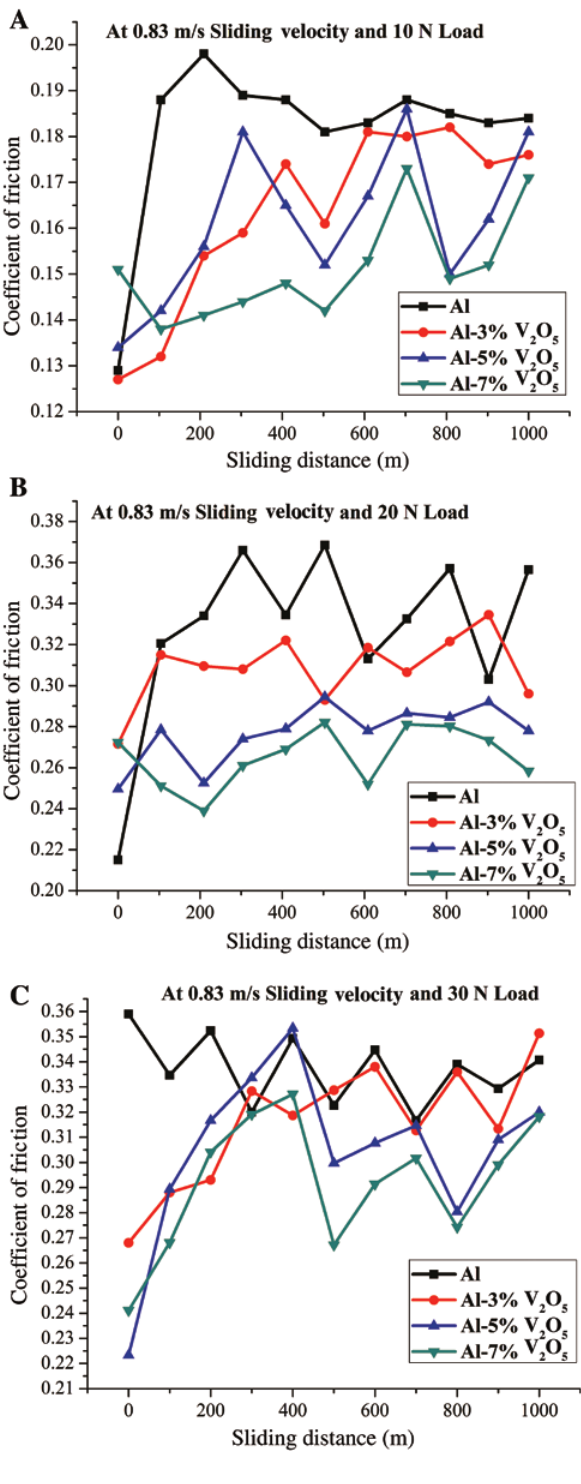
Figure 9: (A) Coefficient of friction as a function of sliding distance at 10 N load; (B) coefficient of friction as a function of sliding dis- tance at 20 N load; (C) coefficient of friction as a function of sliding distance at 30 N